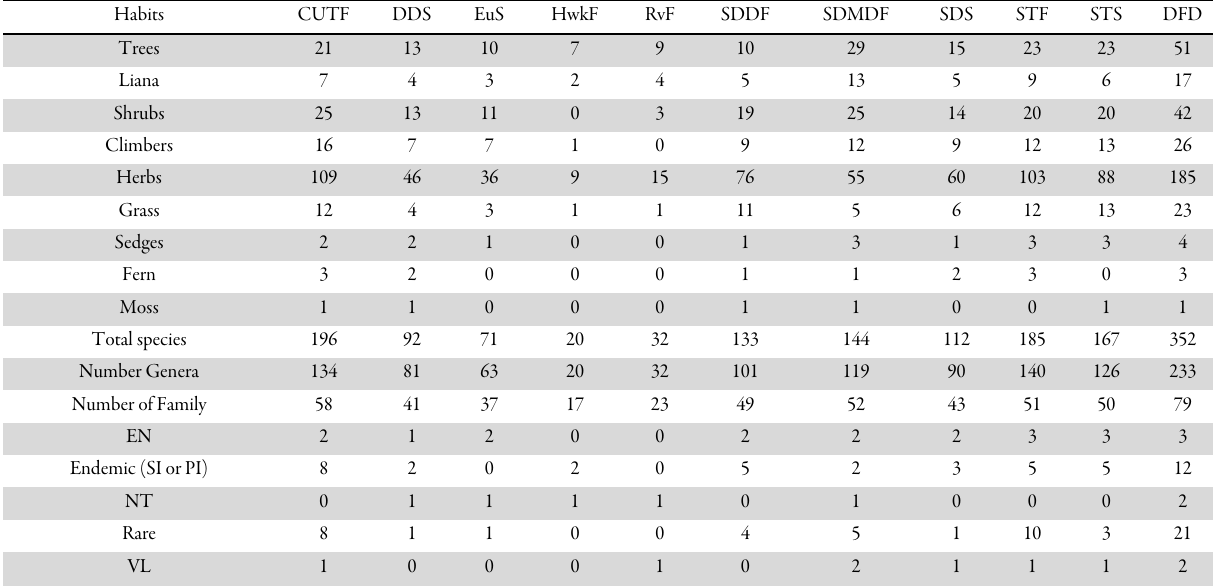
Table 1. Floristic diversity in various forest types of Dharmapuri Forest (DFD)